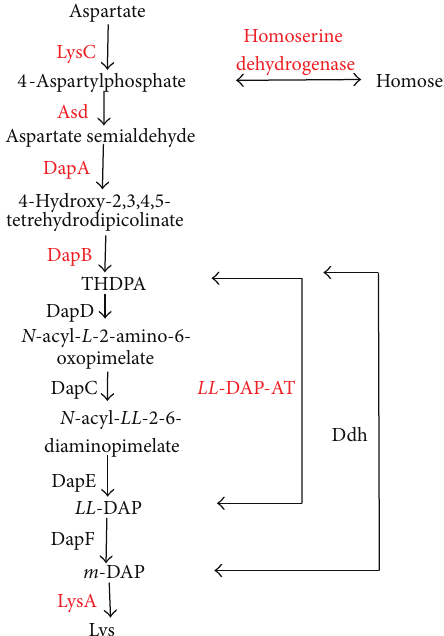
Figure 3: The mechanisms for lysine synthesis. The pathways labeledinthediagramincludethreevariantsthatuseeithersuccinyl- CoA or acetyl-CoA. The first pathways were the acyl-DAP path- ways. Another uses Ddh (DAP dehydrogenase) to directly con- vert THDPA to m -DAP. LL -DAP-AT directly converts THDPA to LL -DAP. Acronyms in the diagram include LsyC, aspartate kinase; Asd, aspartate-semialdehyde dehydrogenase; DapA, dihy- drodipicolinate synthase; DapB, dihydrodipicolinate reductase; THDPA, L -2,3,4,5-tetrahydrodipicolinate; DapD, THDPA acyl- transferase; DapC, N -acyl- L -2-amino-6-oxopimelate aminotrans- ferase; DapE, N -acyl- LL -2,6-diaminopimelate deacylase; LL -DAP, LL -2,5-diaminopimelate; DapF, DAP epimerase; m -DAP, m -2,6- diaminopimelate; LysA, m -DAP decarboxylase; LL -DAP-AT, LL - diaminopimelate aminotransferase; Ddh, m -DAP dehydrogenase. The red words represent upregulated DEGs; the black words rep- resent not